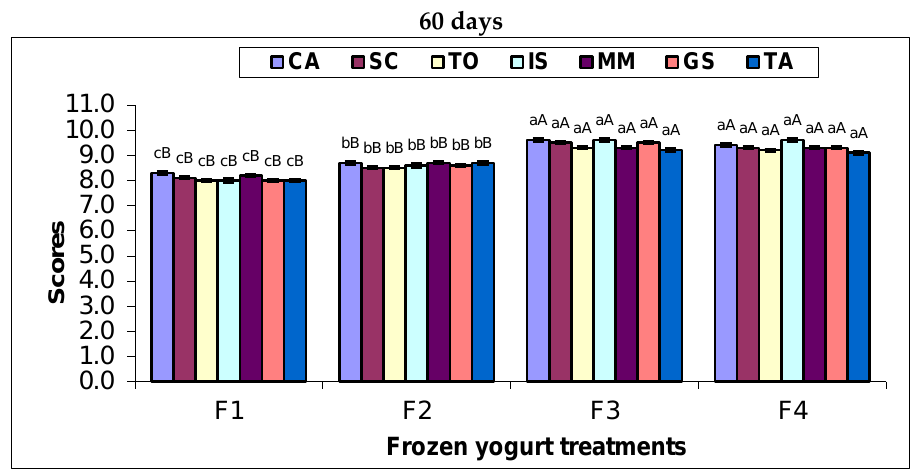
Figure 2. Sensory evaluation of probiotic-frozen yogurt during storage. CA: color and appearance; SC: structure and consistency; TO: taste and odor; IS: icy structure; MM: melt in mouth; GS: gummy structure; TA: total acceptability, F1: Control frozen yogurt; F2: Frozen yogurt with stevia; F3: Frozen yogurt with sucralose; F4: Frozen yogurt with sorbitol; a , b and c : bars and results within the same time frame not sharing a common letter are presented with SE ( p < 0.05).; A and B : bars and results within the same time frame not sharing a common letter are presented with SE ( p < 0.05).